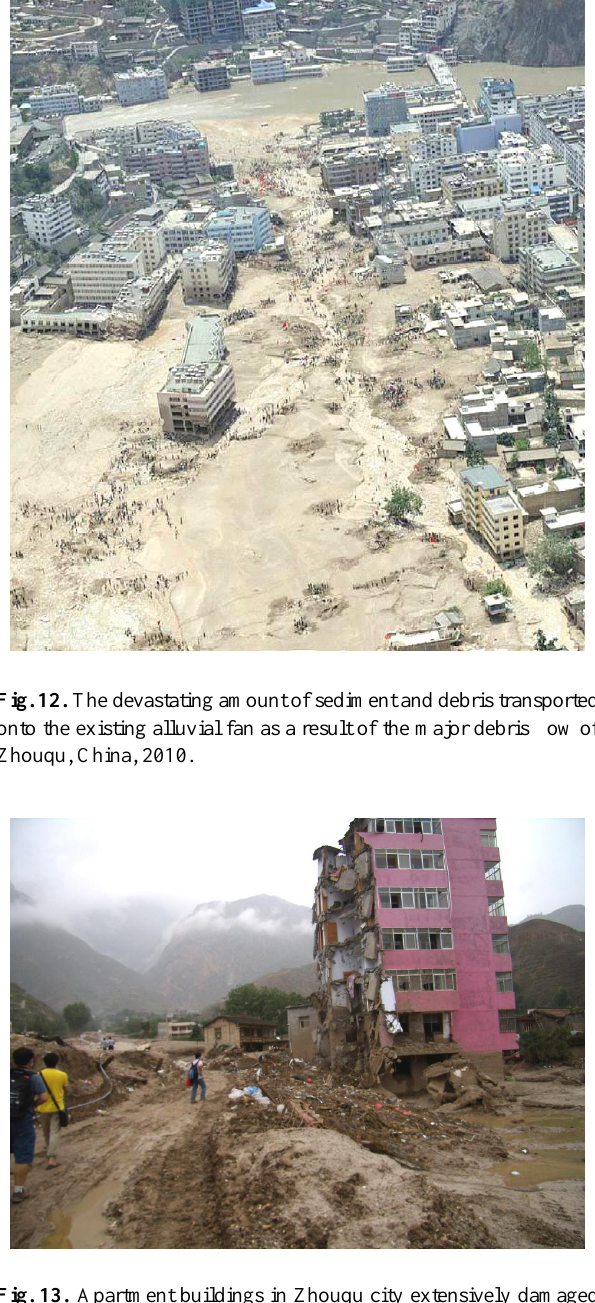
Fig. 13. Apartment buildings in Zhouqu city extensively damaged by the passage of the debris flow front of at least 4m in height.